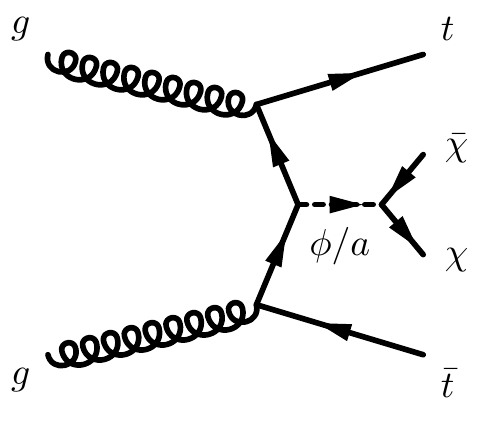
Figure 4 . A representative Feynman diagram for spin-0 mediator production. The (cid:30) / a is the scalar/pseudoscalar mediator, which decays into a pair of dark-matter ( (cid:31) ) particles. (d) Bino/higgsino mix